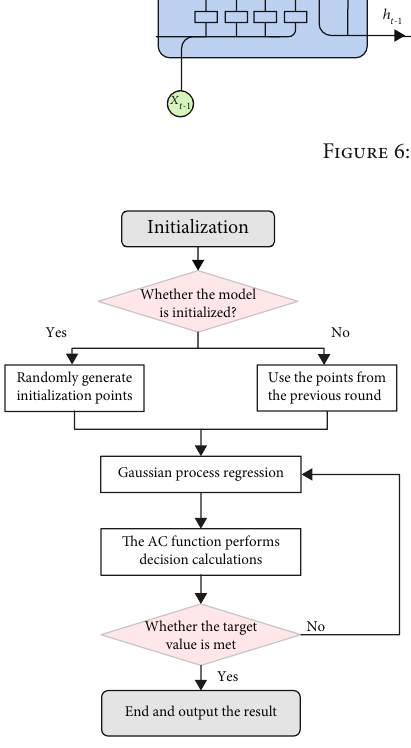
Figure 7: Basic fl ow of the BO Figure 8. It is known that both the structure and model param-